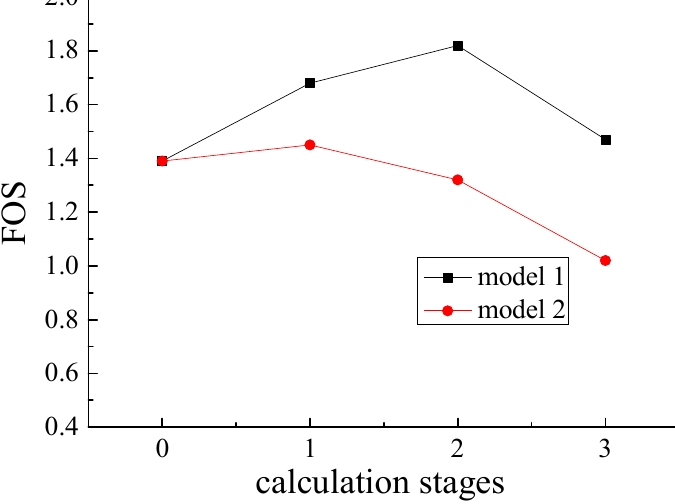
Figure 6. FOSs for the two models at different calculation stages.